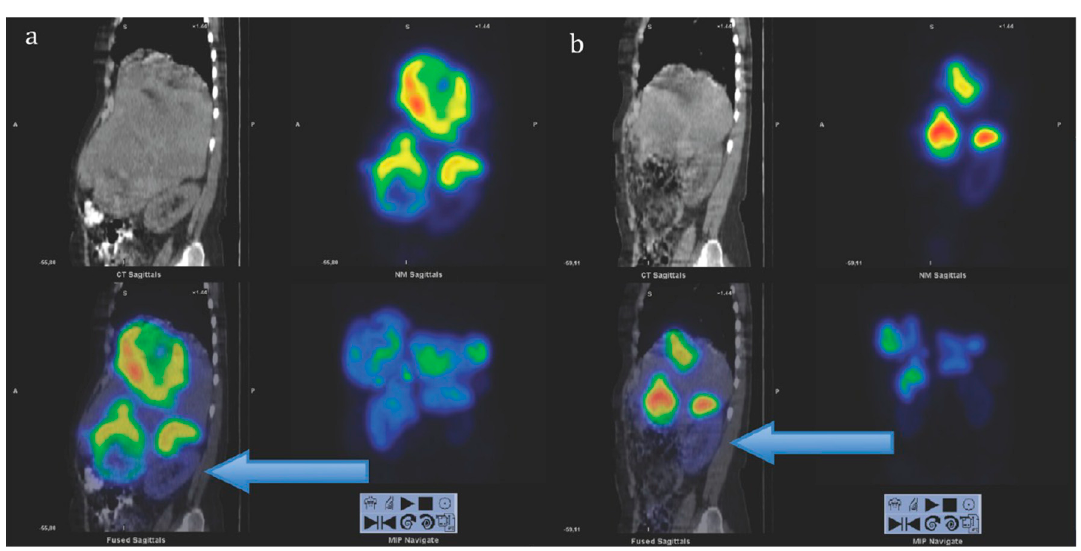
Figure 6. Sagittal views of single photon emission computed tomography (SPECT)-CT over the abdomen at the level of the right kidney, 24 hrs after infusion of 7.4 GBq of [ 177 Lu]Lu-DOTA-octreotate. ( a ) Cycle 1, May 2010 ( b ) cycle 7, August 2011. Left upper corner in each image: Attenuation correction CT, right upper corner attenuation corrected SPECT, left lower corner fused SPECT-CT, right lower corner maximum intensity projection (MIP). Note the position of the right kidney (arrow) and tracer distribution within the tumors. Reproduced from [116].